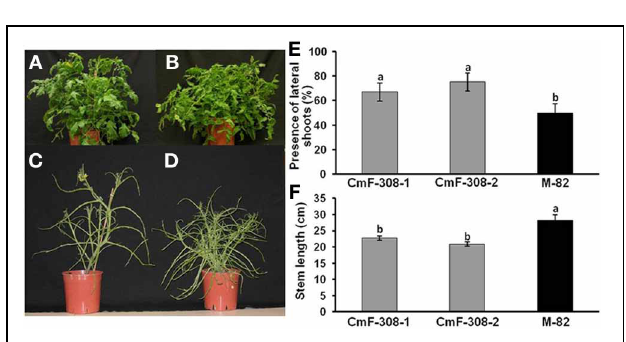
FIGURE 6 | Effect of CmF-308 expression in the phloem of tomato plants on shoot development. Control variety M-82 (A,C) as compared with transgenic plants expressing CmF-308 under the AtSUC2 promoter (B,D) . Pictures were taken 60 days after germination. Plants were stripped of all their leaflets (C,D) to assist in visualizing the branching phenotype. Percentage of lateral shoots (E) and stem length (F) of the control tomato variety M-82 and two transgenic lines expressing CmF-308 under the AtSUC2 promoter, 30 days after germination. Data represent means of 12 replications ± SE. Different letters indicate significant differences between the plant lines at p < 0 . 05 by Student’s t -test.